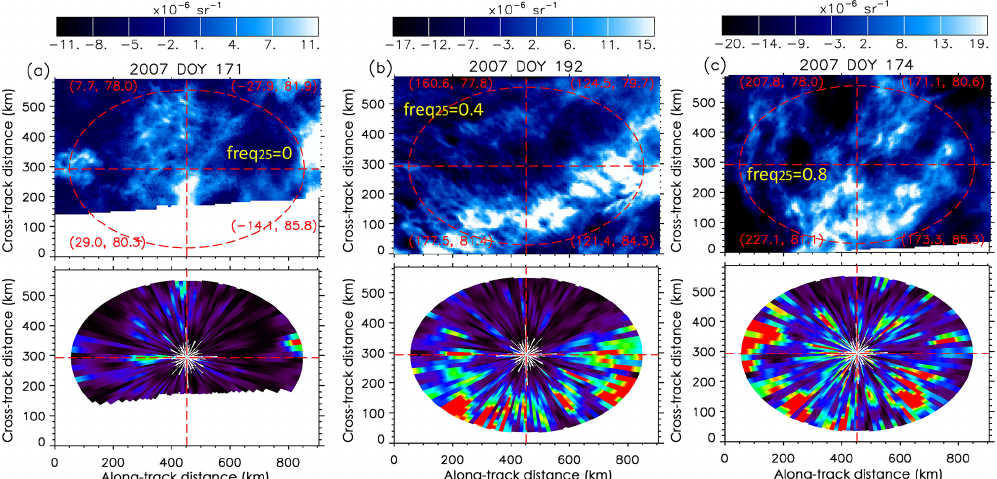
Figure 8. Same as Fig. 7 except for corresponding to the medium-albedo-power category. They are systematically blurrier than those in Fig. 7.